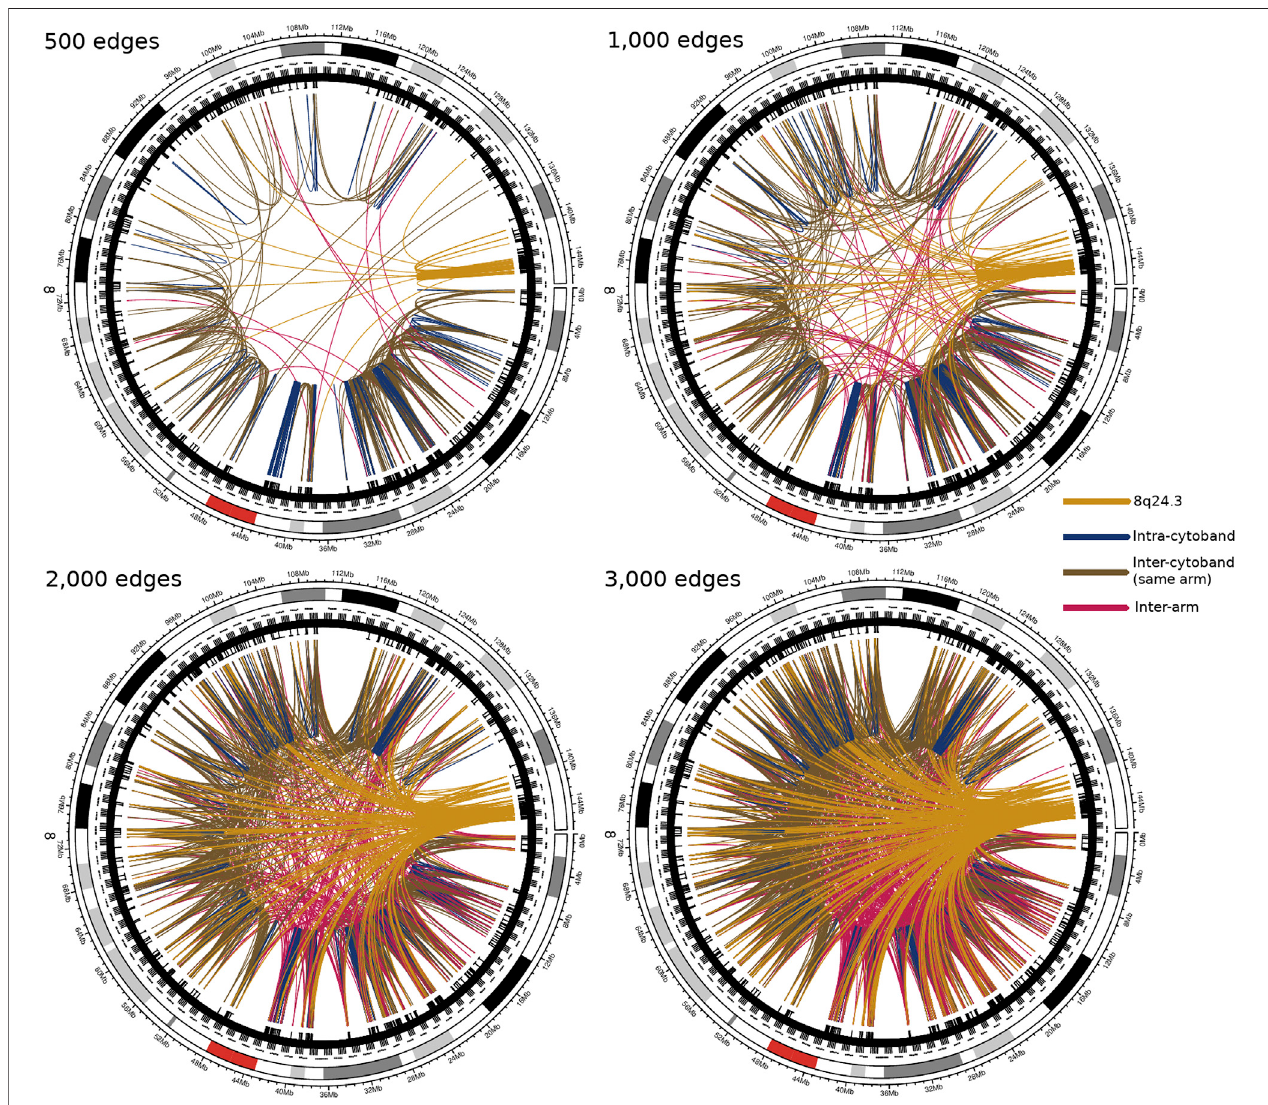
FIGURE 5 | Top interactions of control tissue CMI network at different cut-offs. In this fi gure, analogue to Figure 4 , although both, expression and co-expression are not uniform, many of the strongest links correspond to inter-arm interactions. The color code is the same than in Figure 4 . It is clear the difference between the area coveredbytop-3,000 interactionsincontrolcircos-plot and theoneobserved intheLuminal Bcase. Thedensity oflinks inthecontrolnetworkislarger thanin Figure4 .